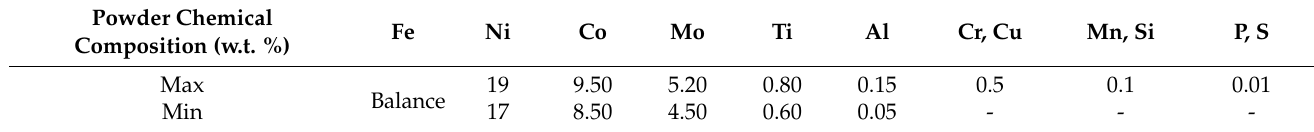
Table 1. The chemical composition of MS1 material